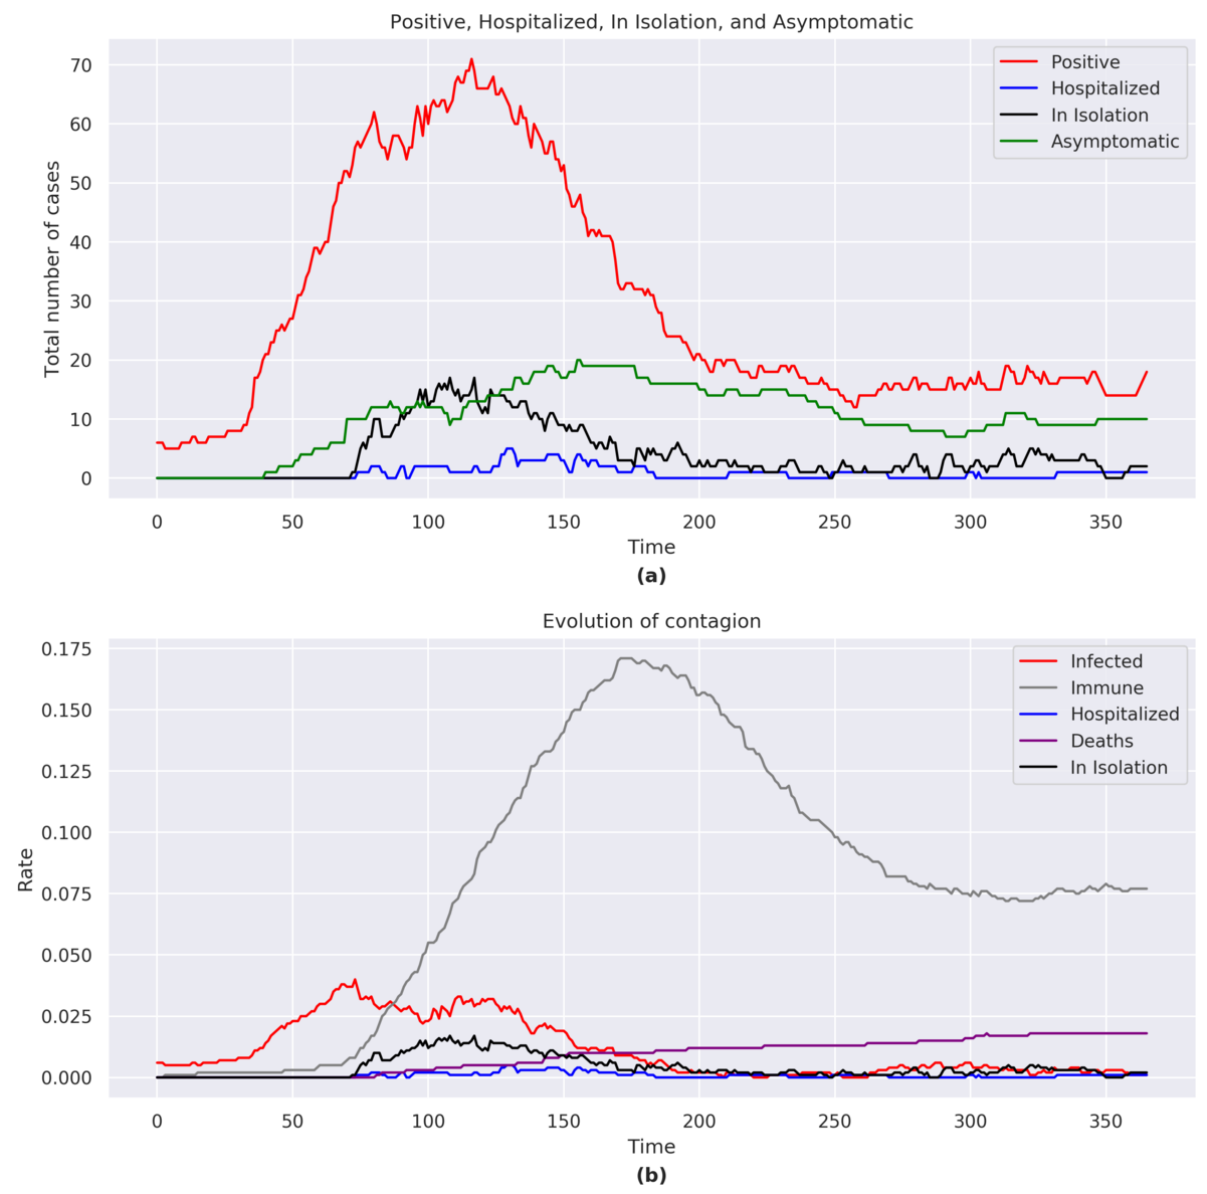
Figure 4. (a) Positive, hospitalized, in isolation, and asymptomatic figures for Germany. (b) Evolution of the contagion for Germany. The graphs consider the sum of the agents belonging to each category shown in the legend for each day of the